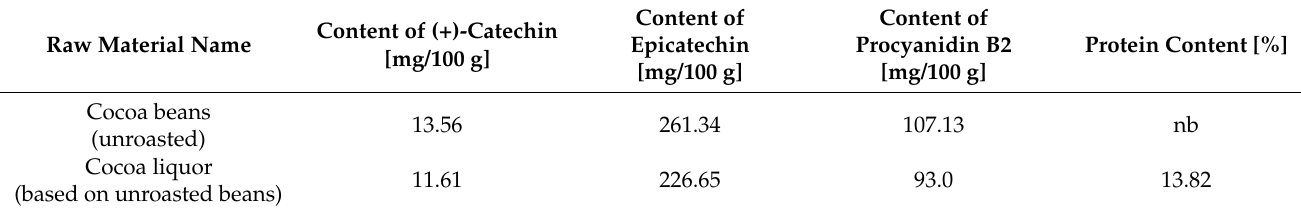
Table 2. Content of major flavonoids and proteins found in raw cocoa materials used for